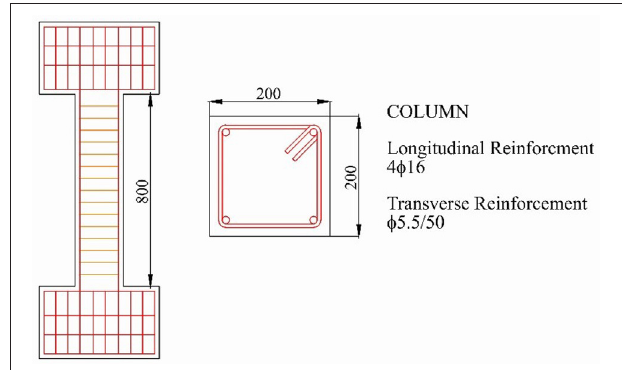
FIGURE 4 | Description of the NDC specimen tested by Ohue et al.